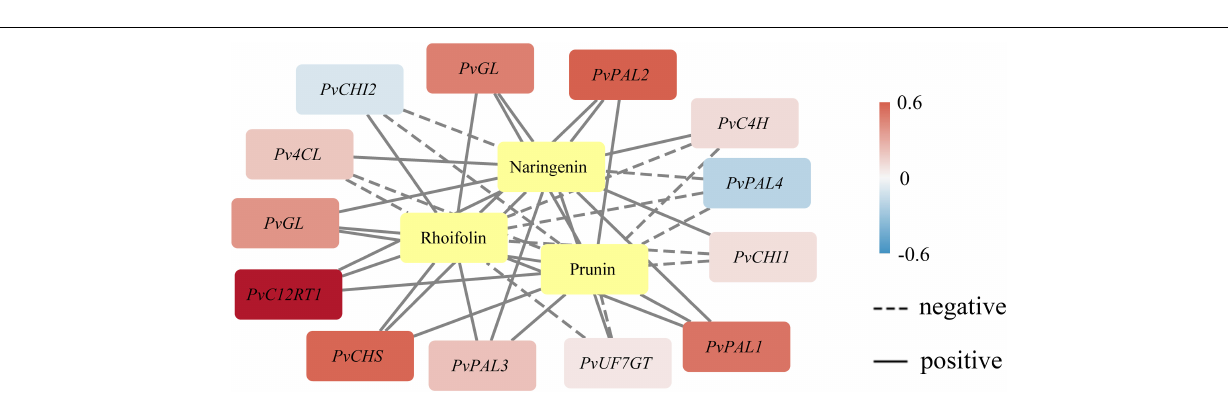
FIGURE 3 | Coexpression analysis of genes related to flavonoid biosynthesis. The yellow color represents metabolites. Pearson correlation coefficients are shown by color range. Correlations between genes and metabolites are designated with black